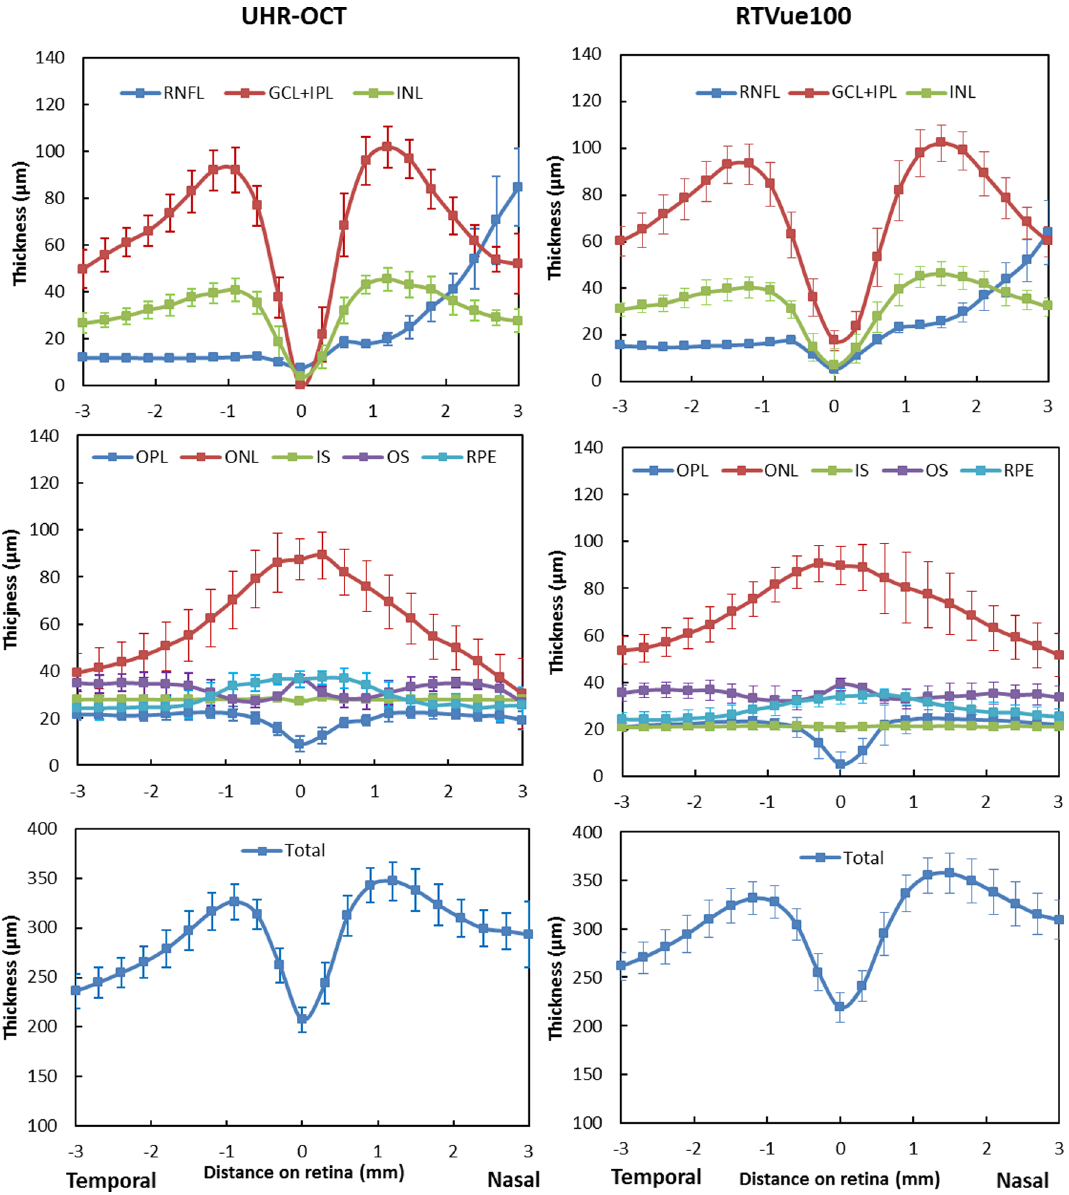
Figure 3.Thickness profiles of eight intra-retinal layers determined from the UHR-OCT and RTVue100 images in the horizontal meridian. Thickness profiles of eight intra-retinal layers along the horizontal meridian were averaged for 20 normal healthy eyes. Error bars represent standard deviation.